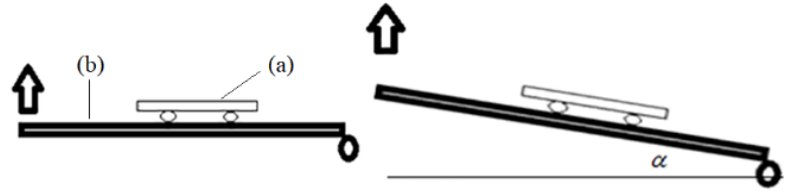
Figure 1. The experimental study on static friction coefficient between proppant and wall.